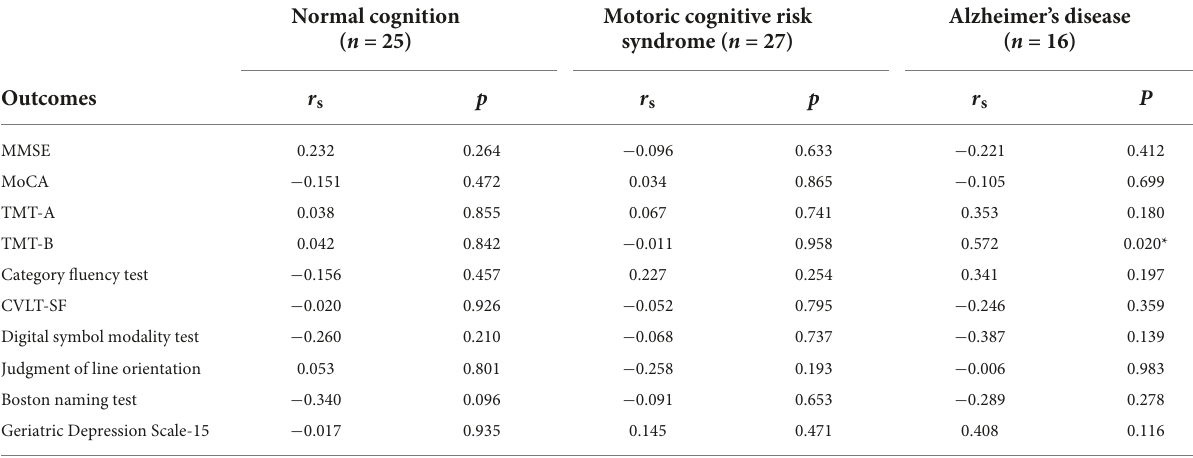
TABLE 3 Associations between plasma A β 42 and cognitive function in the three groups.